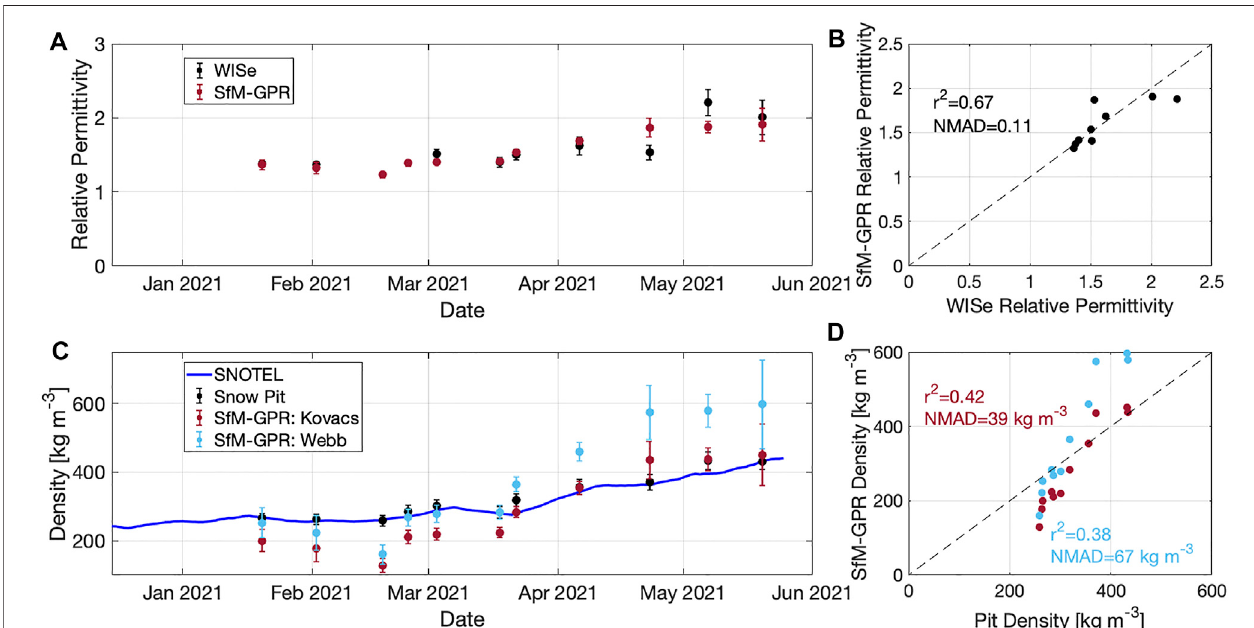
FIGURE6|(A) ComparisonofrelativepermittivitymeasuredbytheA2PhotonicsWISesensorandderivedfromtheSfM-GPRanalysis.TheerrorbarsfortheWISe are based on the standard deviation of the individual layer observations and for the SfM-GPR are the standard deviation of the observations along the transect. (B) Scatterplot of GPR-SfM snow density and pit-measured density. (C) Snow density from the Joe Wright SNOTEL (smoothed with a 14-day window), manual snowpit measurements, and derived from the SfM-GPR analysis. The error bars for the snowpit are ± 6% of the measured density (Proksch et al., 2016) and for the SfM- GPR are the standard deviation of observations along the transect. (D) Scatterplot of GPR-SfM snow density and pit-measured density using both Kovacs et al. (1995; maroon) and Webb et al. (2021; light blue) empirical relations.